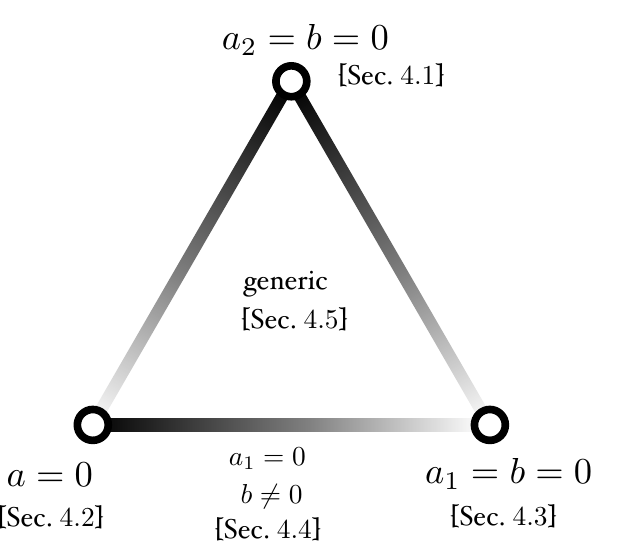
Figure 1 . A summary of the classi(cid:12)cation in this section. The interior of the triangle represents the generic case where none of the parameters vanish, and the sides and vertices represent the various particular cases; recall a 1 Re a , a 2 Im a . The shading of the sides is meant to suggest which (cid:17) (cid:17) limits reproduce the cases represented by the vertices. For example, if one takes the equations for the a 1 = 0 case (lower side) and takes the a 2 0 limit, one recovers the equations of the a = 0 ! case, while the same is not true if one takes the b 0 !